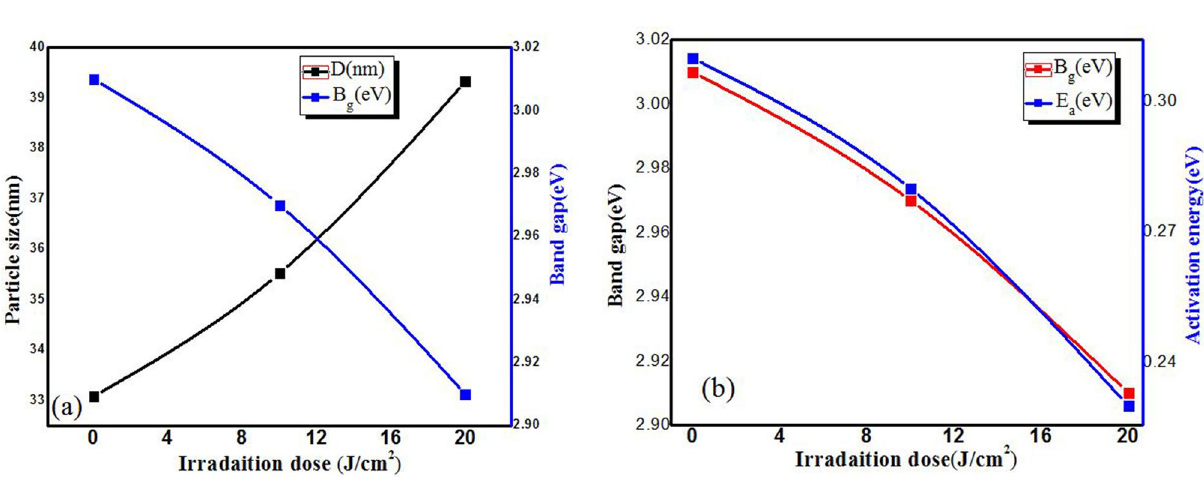
Figure 9. ( a ) Correlation between particle size Vs band gap ( b ) Correlation between band gap Vs activation energy with respect to irradiation dose of ZnO-CdO coated